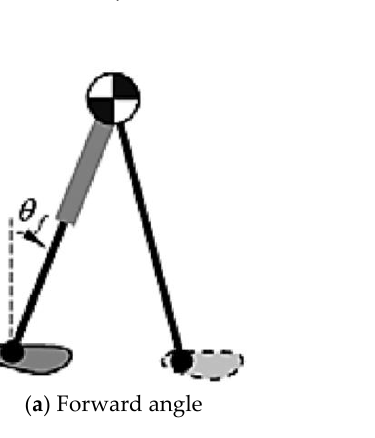
Figure 6. The angle between the support leg and the vertical direction.